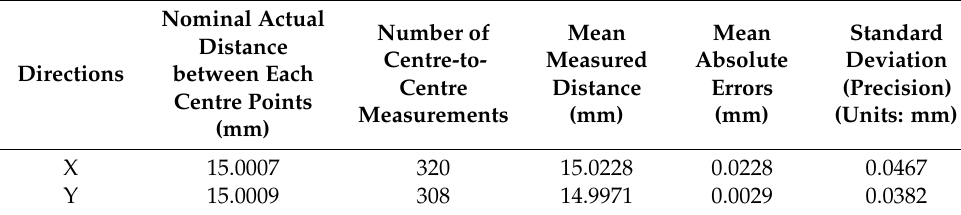
Table 1. Details of the accuracy and precision along transverse direction.